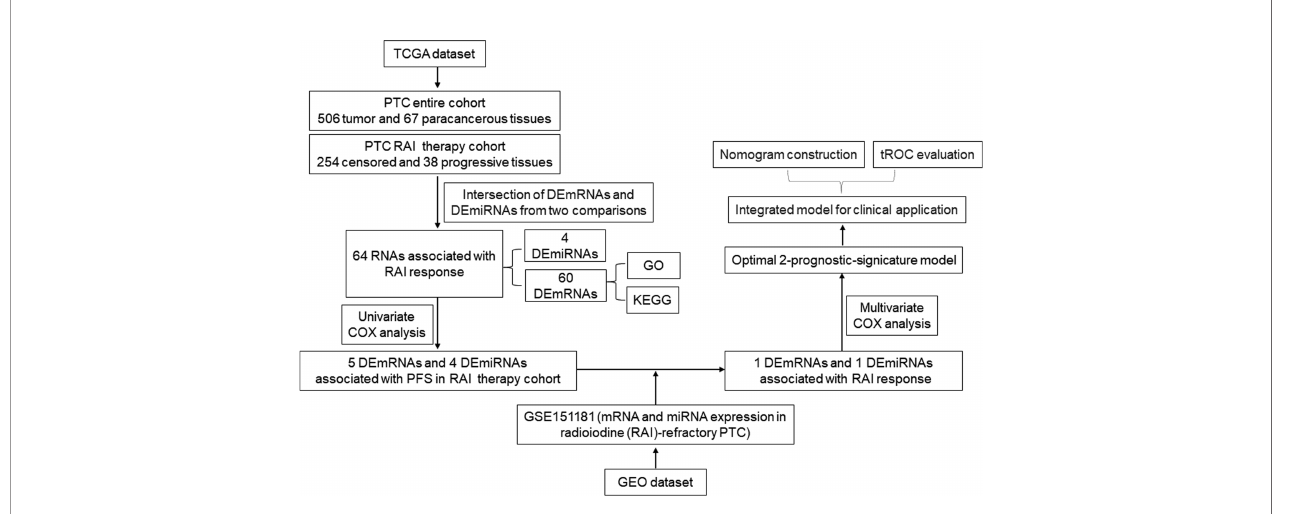
FIGURE 1 | The work fl ow of the bioinformatic